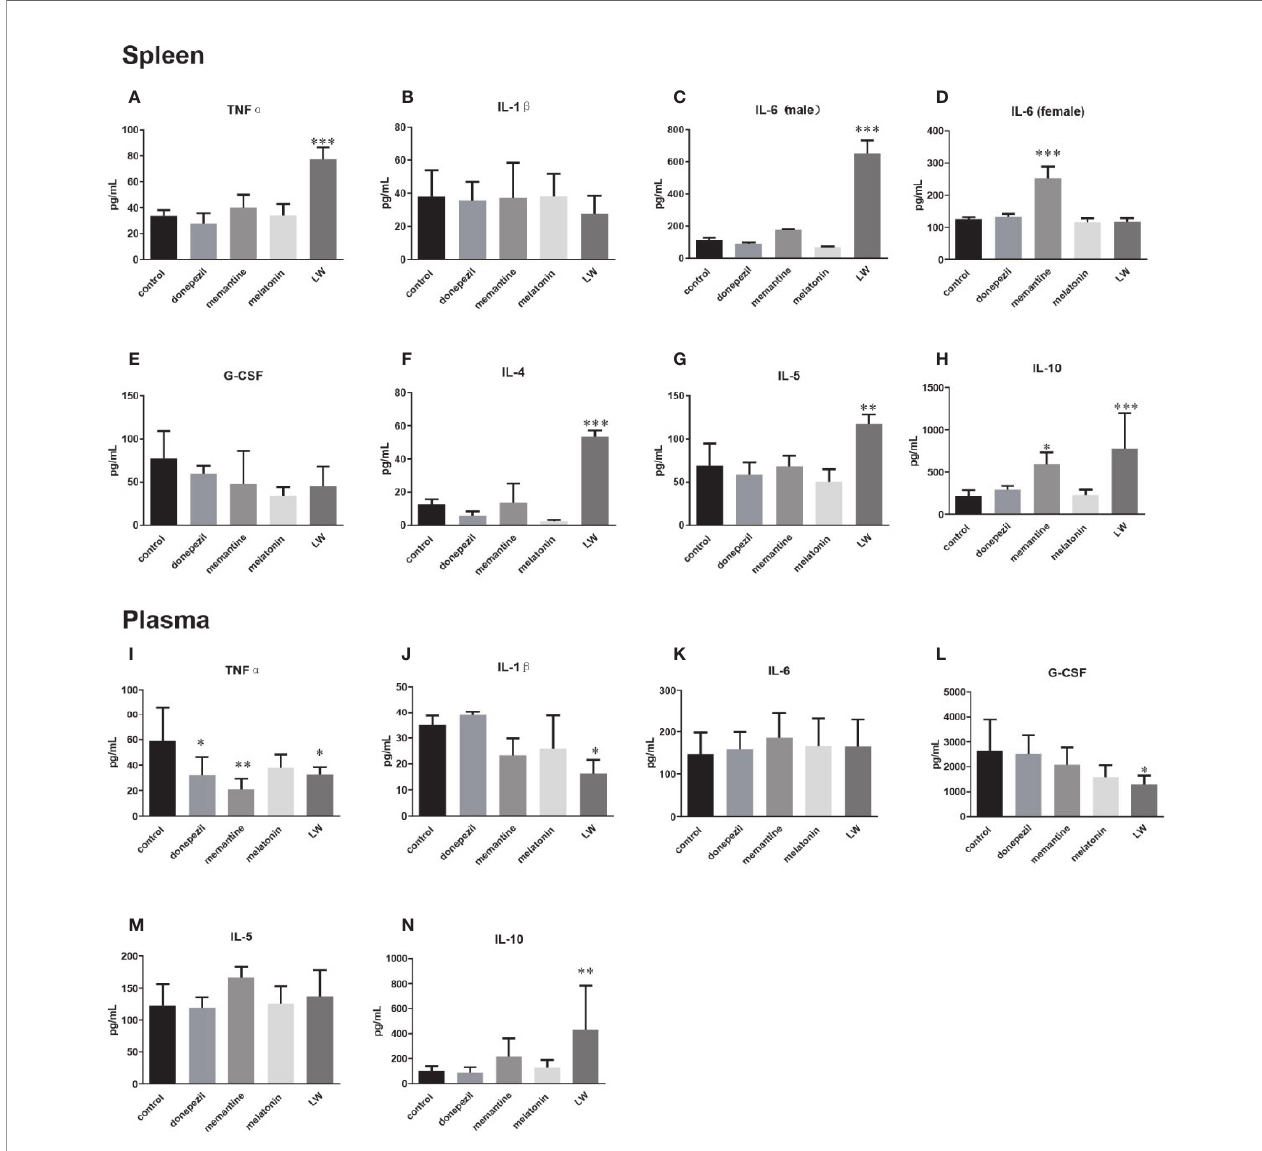
FIGURE 5 | Effects of donepezil, memantine, melatonin, and LW on cytokine levels in the splenocyte culture supernatant and plasma of old SAMR1 mice. After the behavior testes, the mice were sacri fi ced, and spleen cells isolated from the spleen were harvested, 5×10 5 cell/mL was seeded in 96-well plates, cultured for 56 h, and then the supernatants were harvested for cytokine detection. (A, I) tumor necrosis factor a (TNF- a ), (B, J) interleukin-1 b (IL-1 b ), (C, D, K) interleukin-6 (IL-6), (E, L) granulocyte colony stimulating factor (G-CSF), (F) interleukin-4 (IL-4), (G, M) interleukin-5 (IL-5), (H, N) interleukin-10 (IL-10). * P < 0.05, ** P < 0.01, *** P < 0.001, vs control, one-way ANOVA and Dunnett test, Kruskal-Wallis test. mean ± S.D., n = 6~9(male: n=2~4, female: